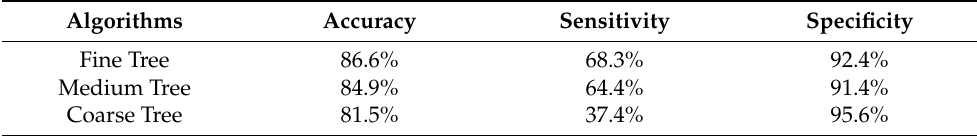
Table A4. Detailed classification performance of discriminant analysis